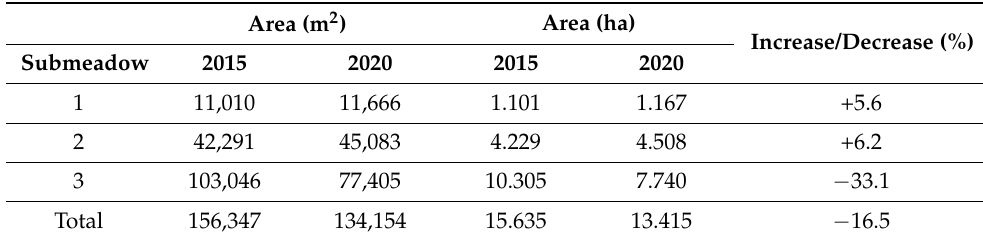
Table 4. Submeadow and entire meadow surfaces in 2015 and 2020, with the indication of increase or decrease (%) estimated in 2020.